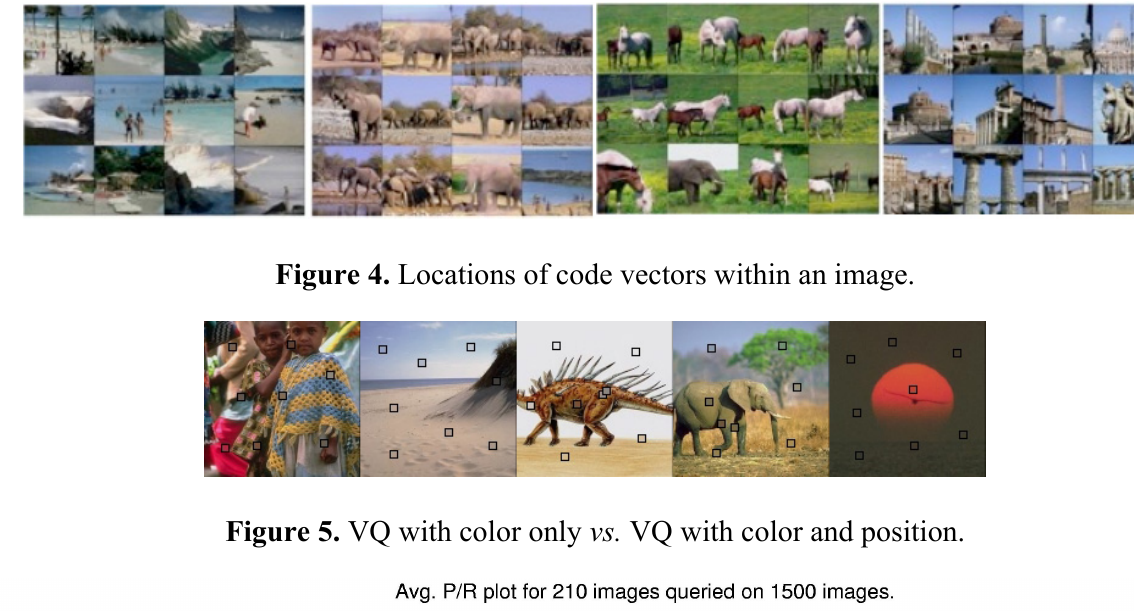
Figure 3. Sample results.